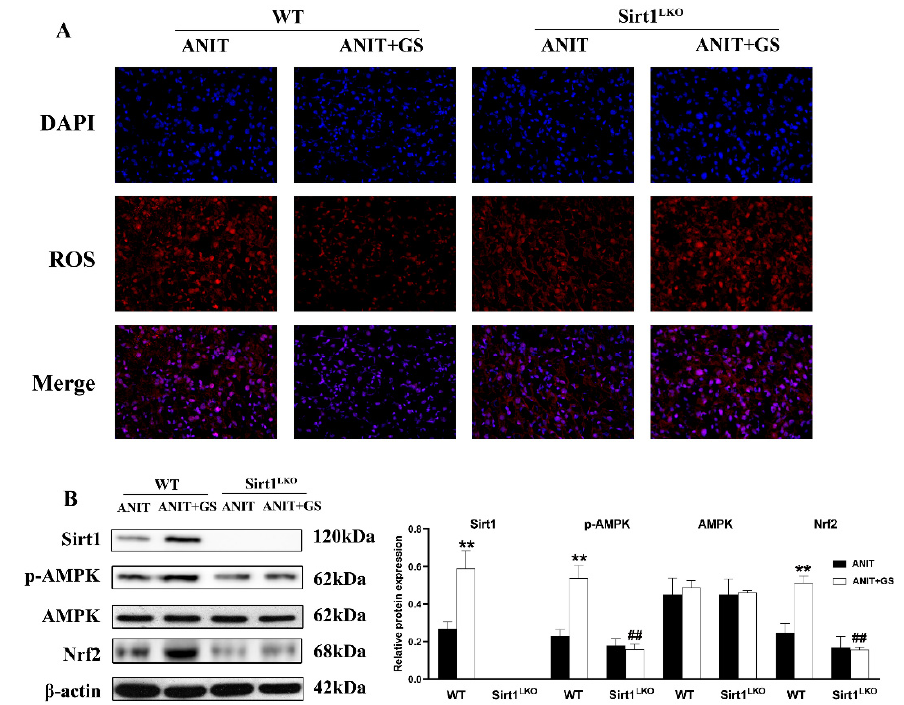
Figure 10. GS-induced activation of the SIRT1/AMPK signaling pathway was significantly reversed in SIRT1 LKO mice. ( A ) Immunofluorescent staining for ROS levels in liver tissue. ( B ) Protein levels of SIRT1, p-AMPK, AMPK, and Nrf2 levels in WT and SIRT1 LKO after GS treatment. Significantly different from ANIT (WT), ** p < 0.01, or ANIT+GS (WT), ## p < 0.01.